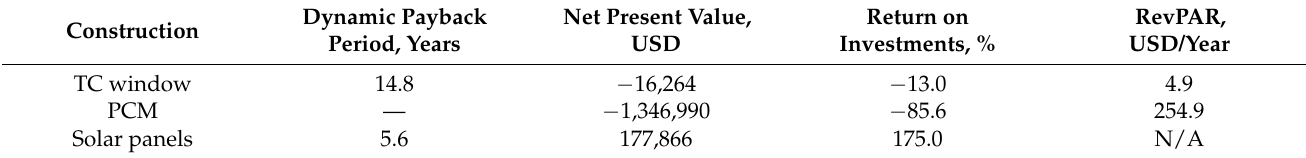
Table 7. Payback period and return on investments for TC window, PCM, and solar panels.